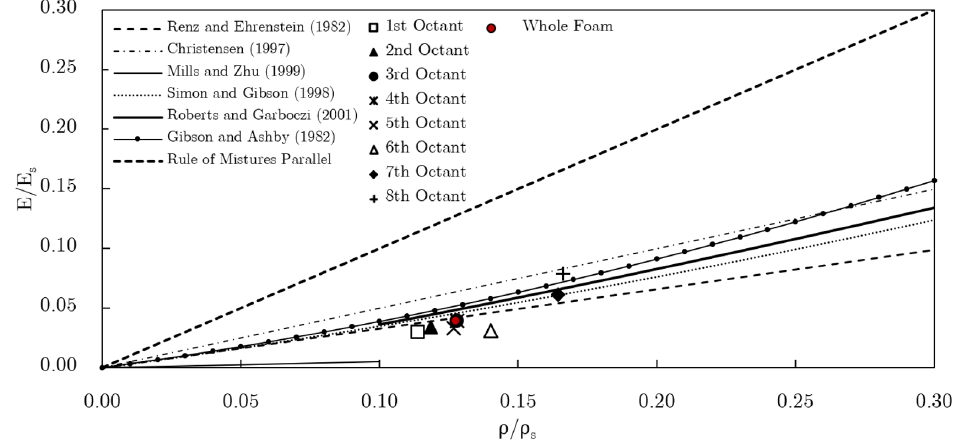
Figure 16. Relative Young’s modulus for the closed-cell foam and the different octants for Procedure 1, i.e., plain